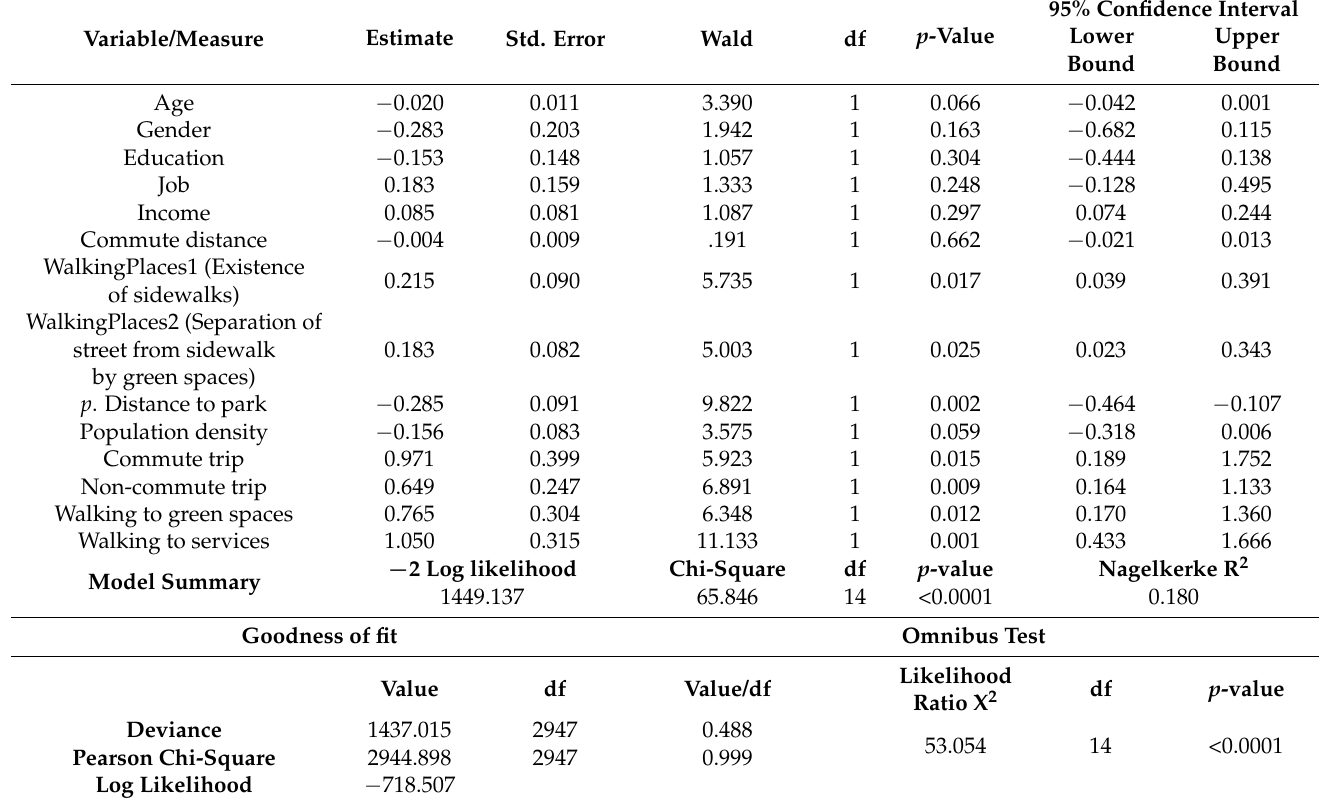
Table 5. Model for the association between active lifestyle and peaceful